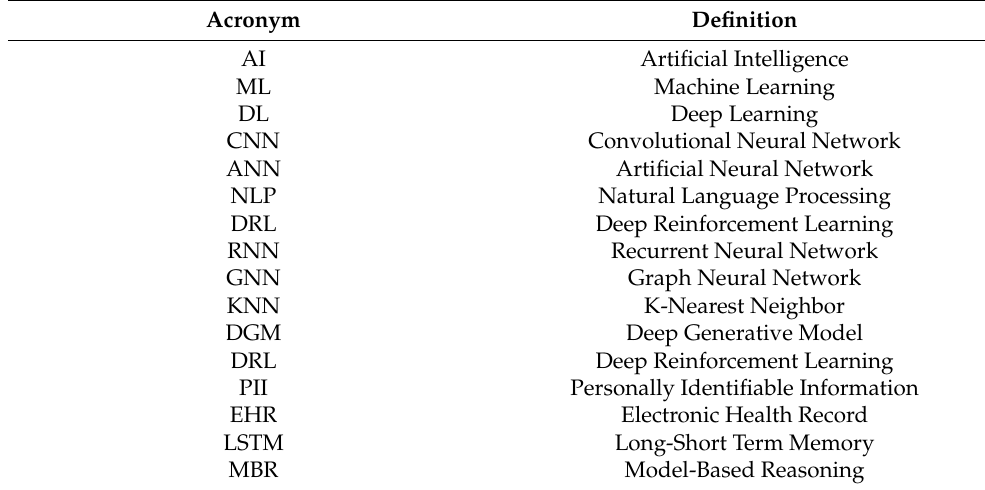
Table 1. List of abbreviations used along with their full form. Acronym